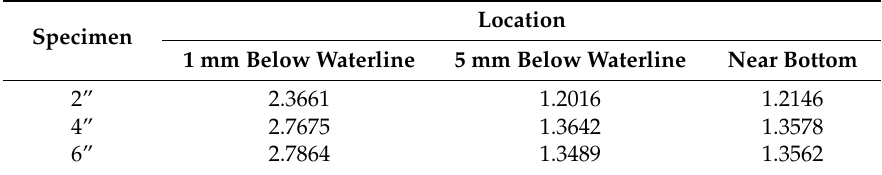
Figure 12. Morphology of specimen partly immersed in simulated condensate: ( a ) key positions, A—area with corrosion rate of 0 mm/y, B—waterline, C—area near the bottom; ( b ) change in thickness near the waterline. Table 7. Corrosion rate for specimens partly immersed in simulated condensate water (mm/y).